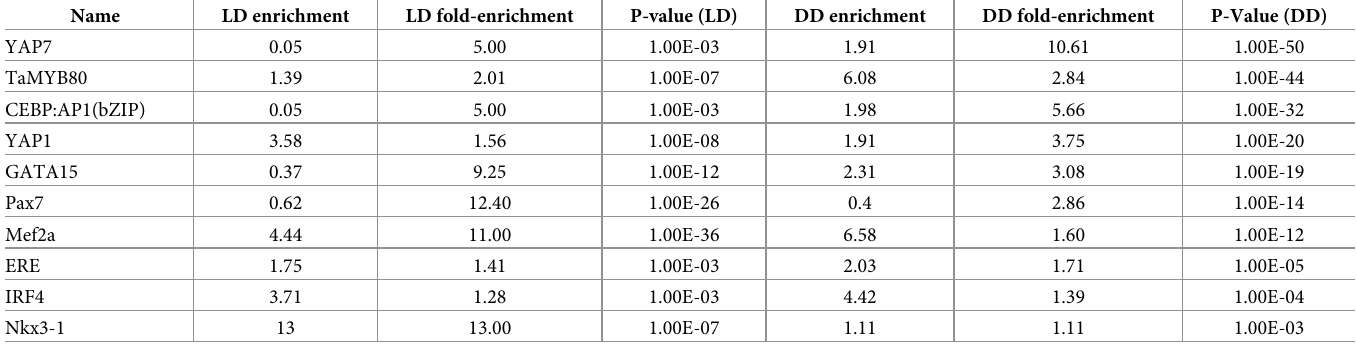
Table 3. Treatments common